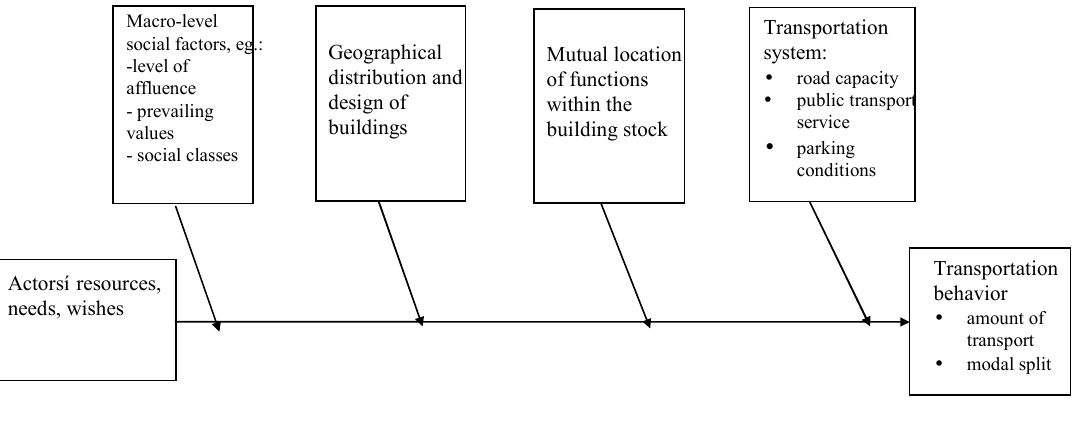
Figure 1. Transportation behaviour as a function of land use characteristics as well as individual characteristics of the